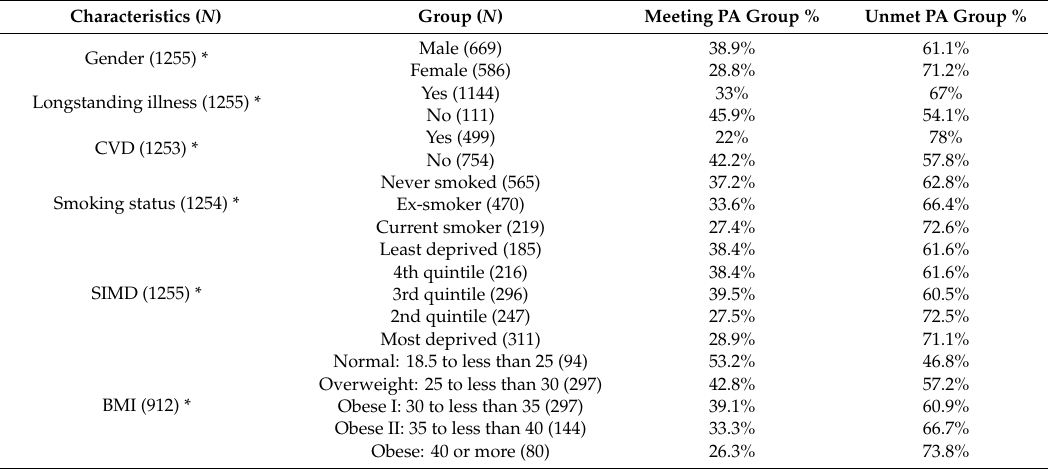
Table 1. The proportion of participants meeting and not meeting the recommended levels of physical activity.